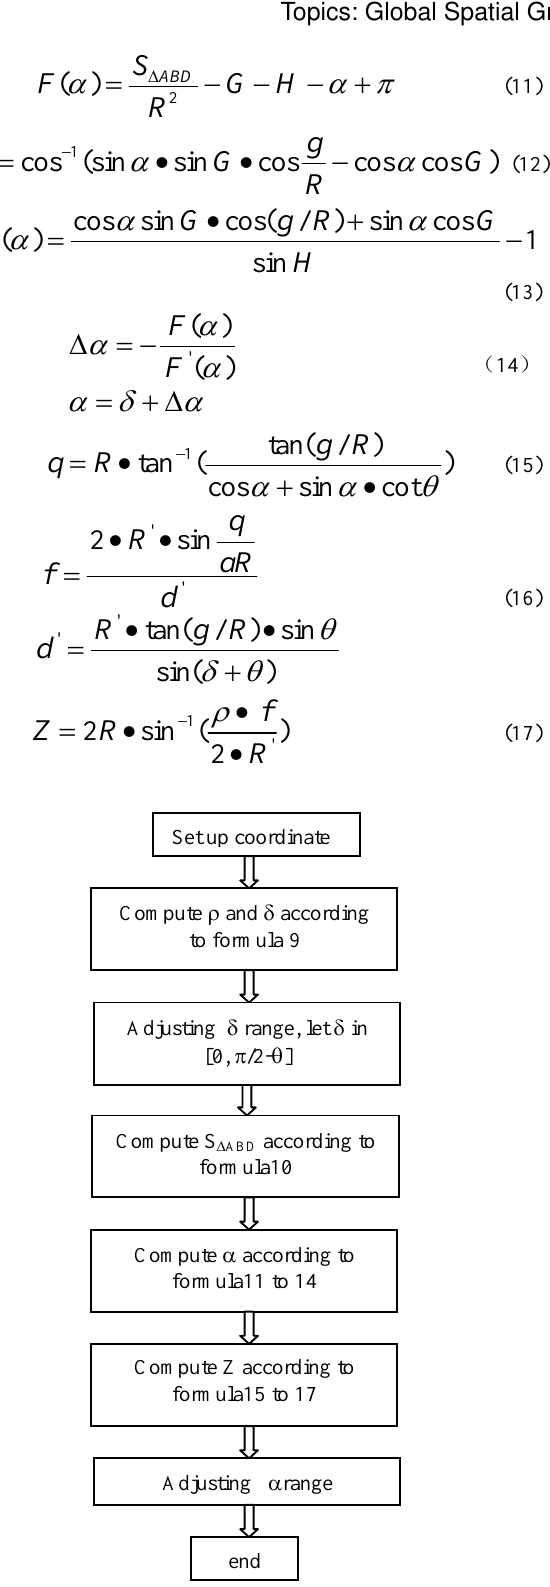
Figure 6 The flow chart of Snyder back projection